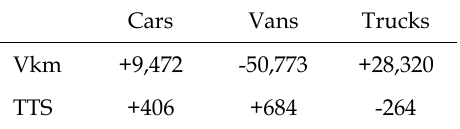
Vkm and TTS from traffic